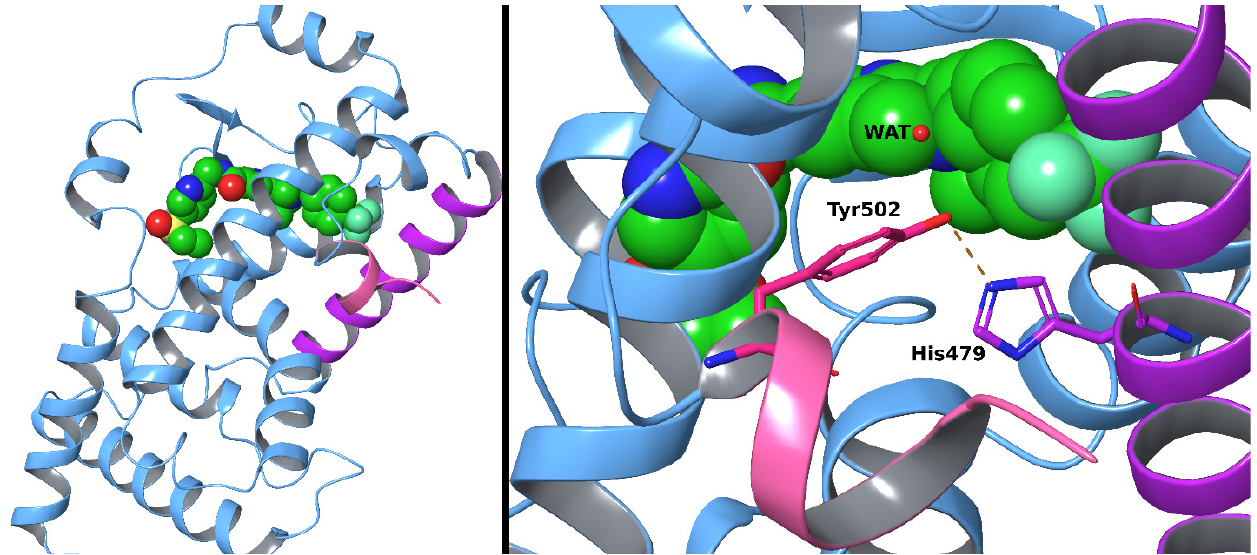
Figure 1. Retinoic acid receptor-related orphan receptor gamma t ligand binding domain. On the left is a 3D-structure of the ligand-binding domain of retinoic acid receptor-related orphan receptor gamma t (ROR γ t; PDB: 5NTW, cartoon representation) with a co-crystallized inverse agonist (CPK model with green carbons). On the right, the H-bond (orange dashed line) formed between His479 and Tyr502 (magenta and pink stick carbons, respectively) in helices 11 and 12 (magenta and pink cartoons, respectively) is shown. The atom coloring for O, N, S, and F is set to red, blue, yellow, and light green, respectively. Water (WAT) is shown as a red sphere.